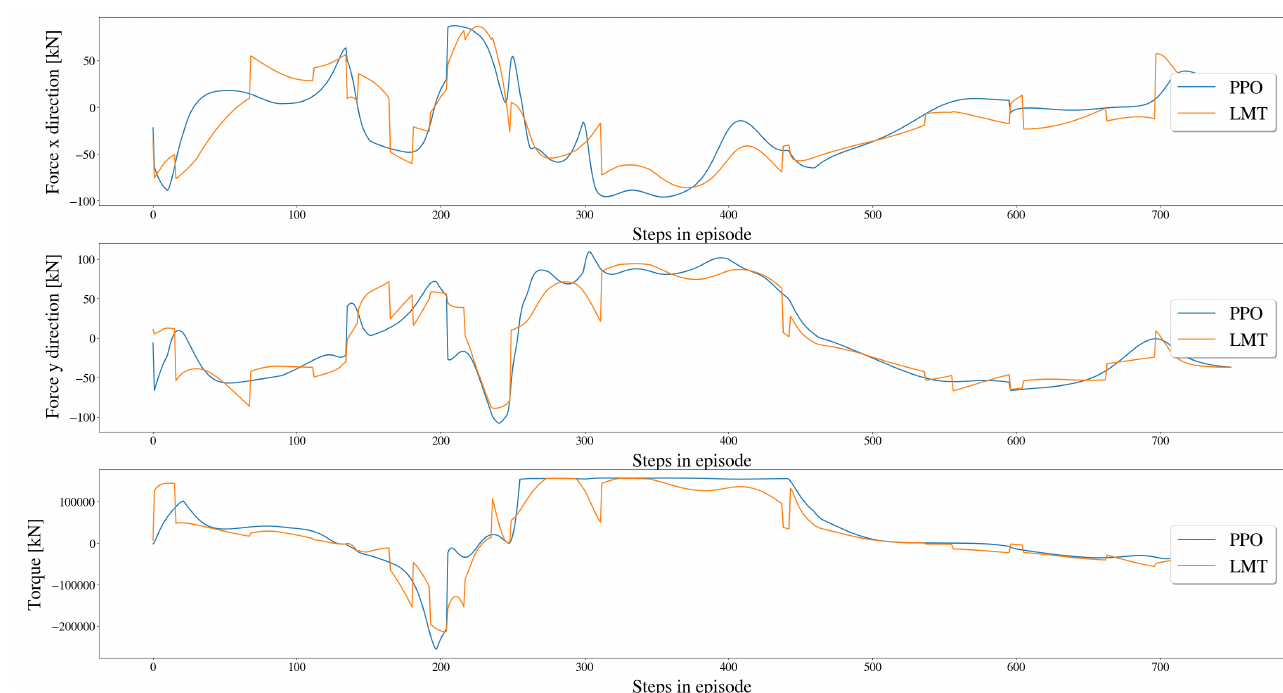
Figure 10. Plot of total force and moment predicted by both the LMT and the PPO-policy for an episode where the PPO-policy actions are given to the